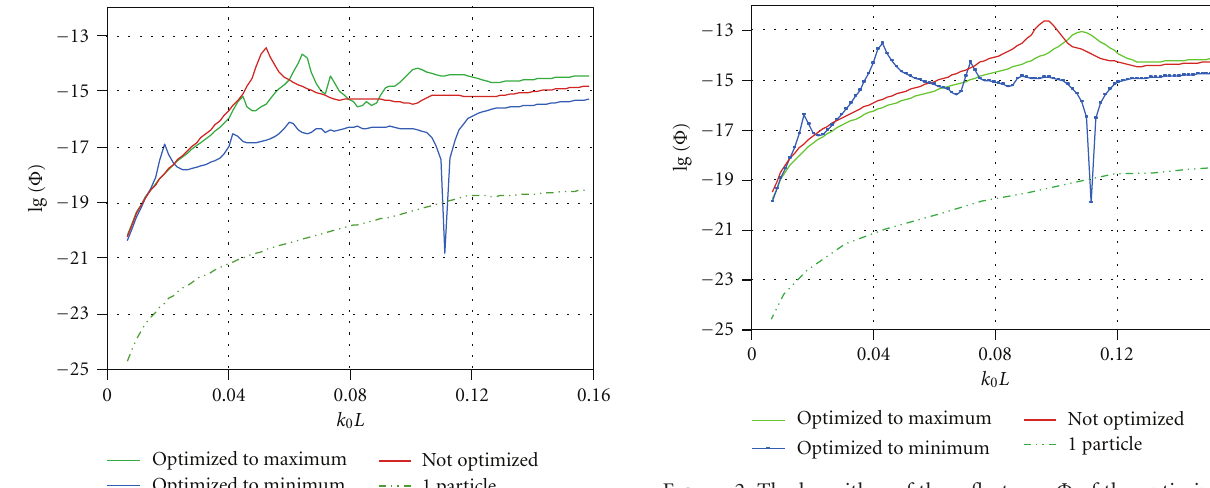
Figure 2: The logarithm of the reflectance Φ of the optimized Au cluster versus the normalized frequency k 0 L . The reflectance was optimized for the frequency k 0 L = 0 . 11 at the observation point r ob = { 0 . 87,0 . 5,0 . 00 } . The period of the cluster is d = 3 . 3 L and L = 10nm. The green and the blue curves show the reflectance of the cluster optimized for maximal and minimal values, respectively. The red curve shows the reflectance of the nonoptimized cluster, and the green dash-dotted curve shows the reflectance of the single Au cube with the characteristic size L .